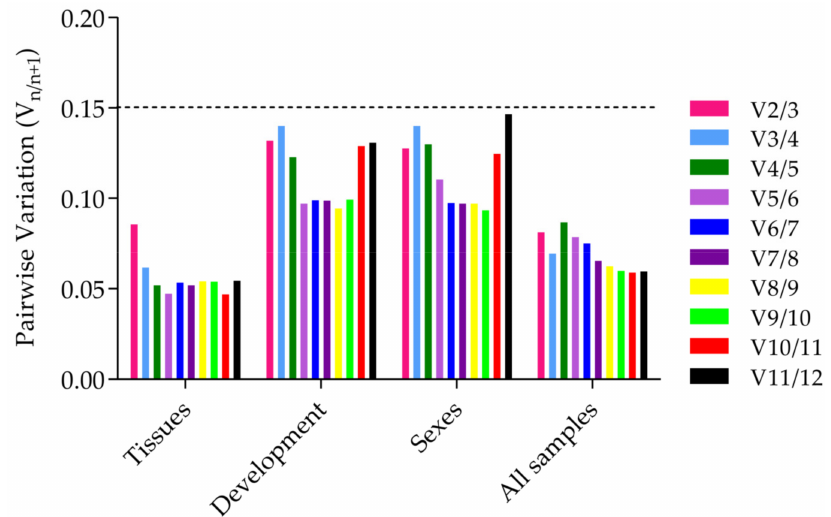
Figure 4. Pairwise variation (V) values using geNorm, based on the different tissues, developmental stages, sexes, and in all